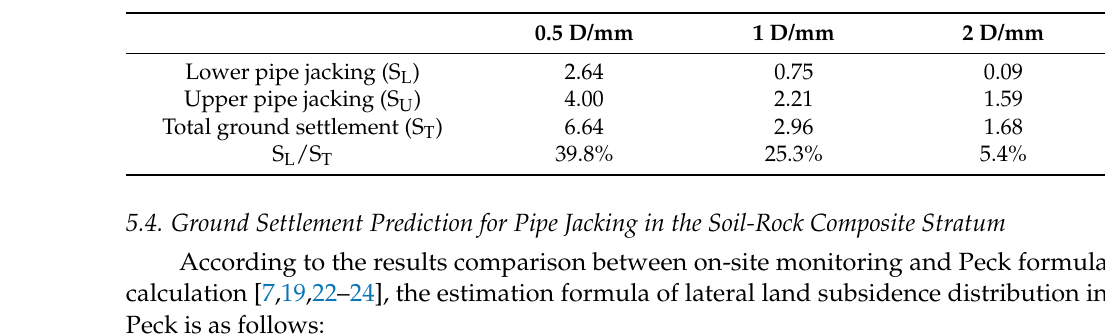
Figure 12. Comparison of ground settlement at different vertical clear spacing. ( a ) Vertical arrange- ment of pipe; ( b ) ground settlement. Table 3. Ground settlements at different vertical clear